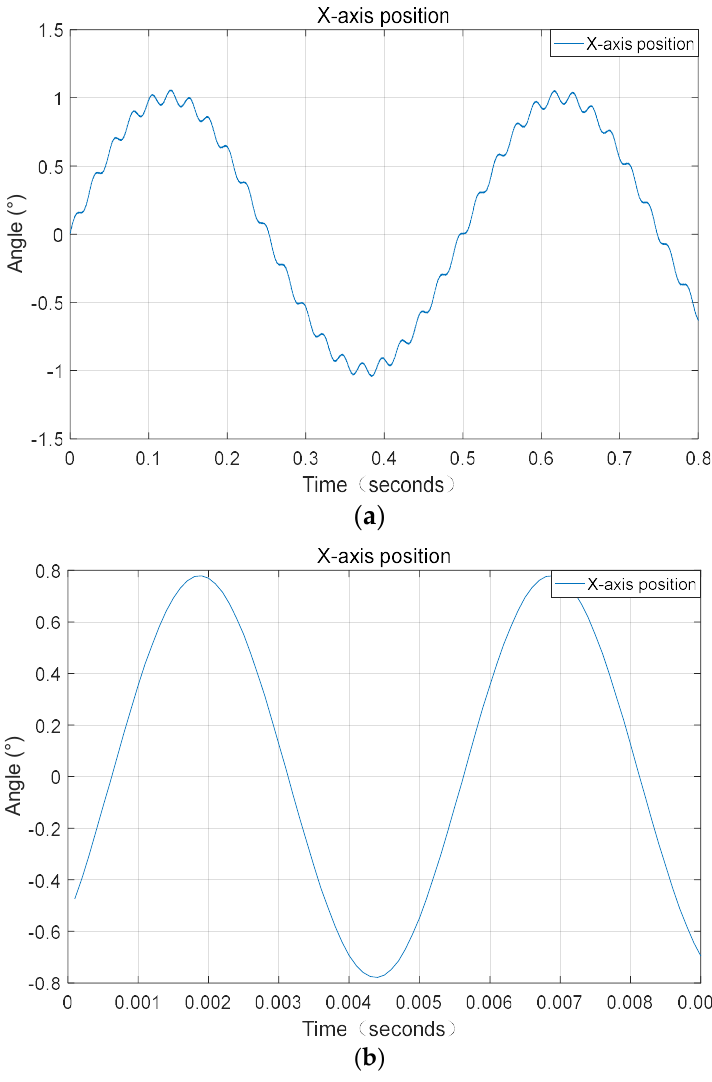
Figure 5. Comparison of position curves before and after resonance suppression. ( a ) Before suppressing resonance; ( b ) after suppressing resonance, the X-axis shows a 200 Hz sinusoidal position curve.